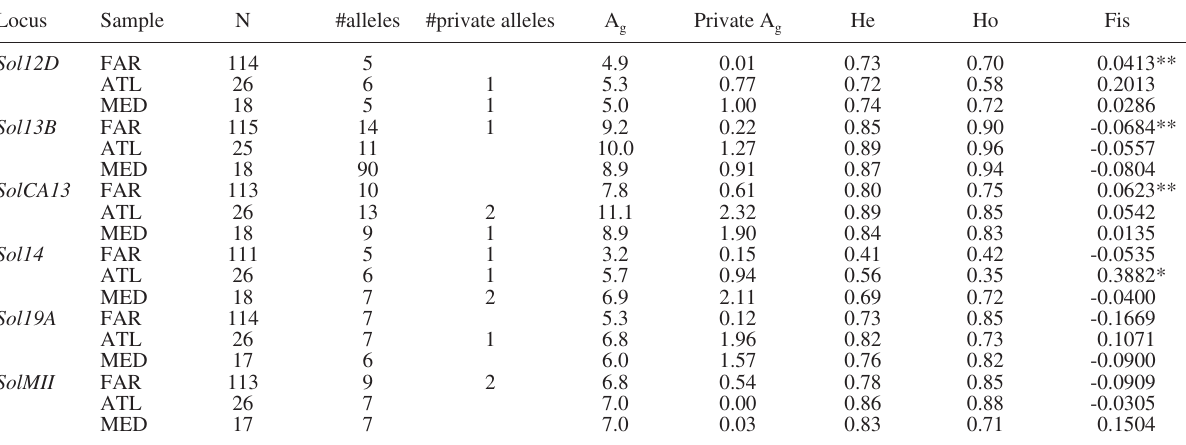
Private A He Ho Fis g g